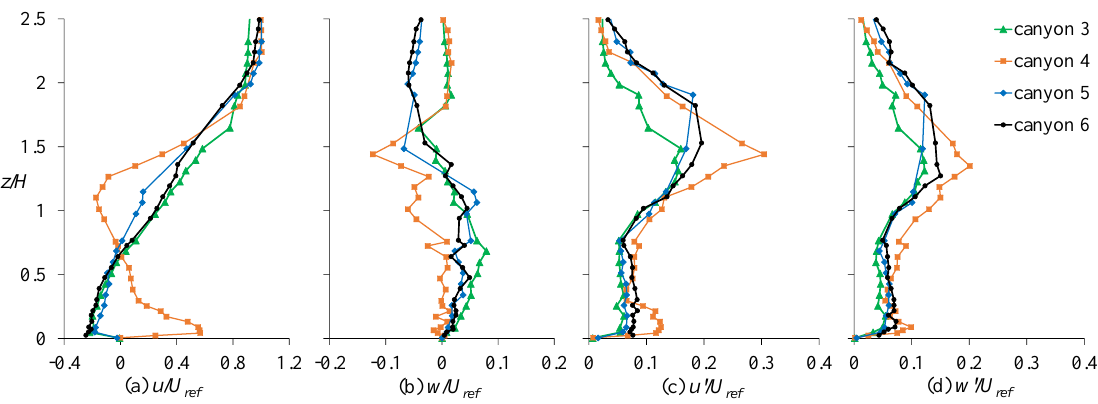
Figure 6. Normalized middle-line velocity profiles of canyons 3–6 with a wind catcher above canyon 4. ( a ) mean stream-wise velocity, ( b ) mean vertical velocity, ( c ) stream-wise velocity fluctuation, and ( d ) vertical velocity fluctuation.